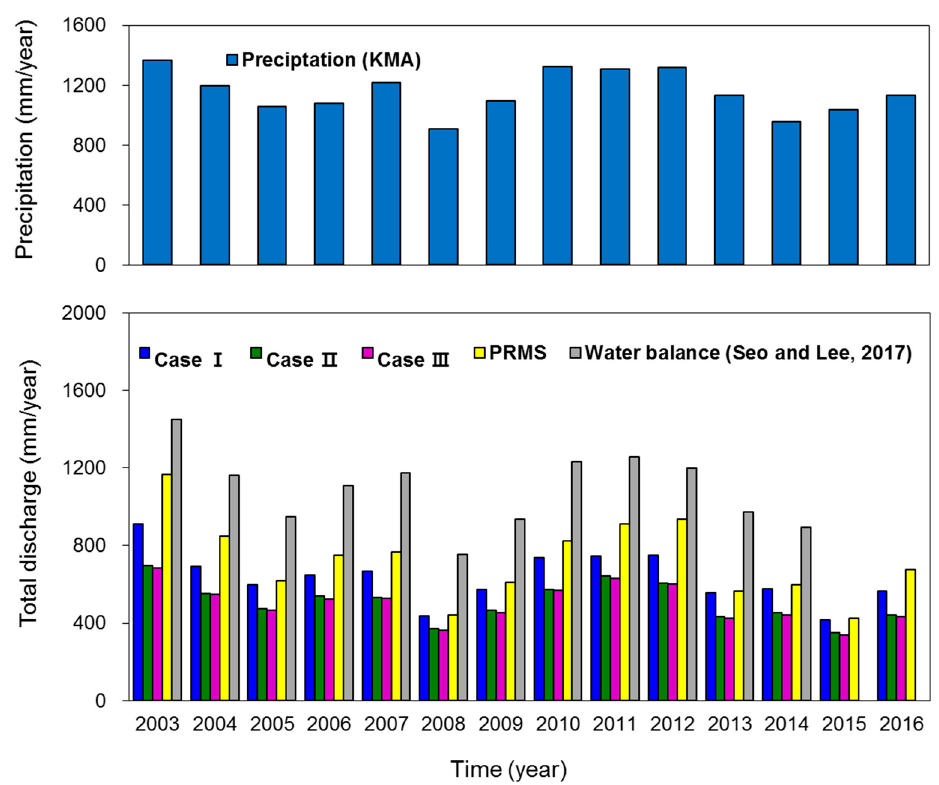
Figure 12. The precipitation and comparison of the average total discharges of the major river basins in South Korea.